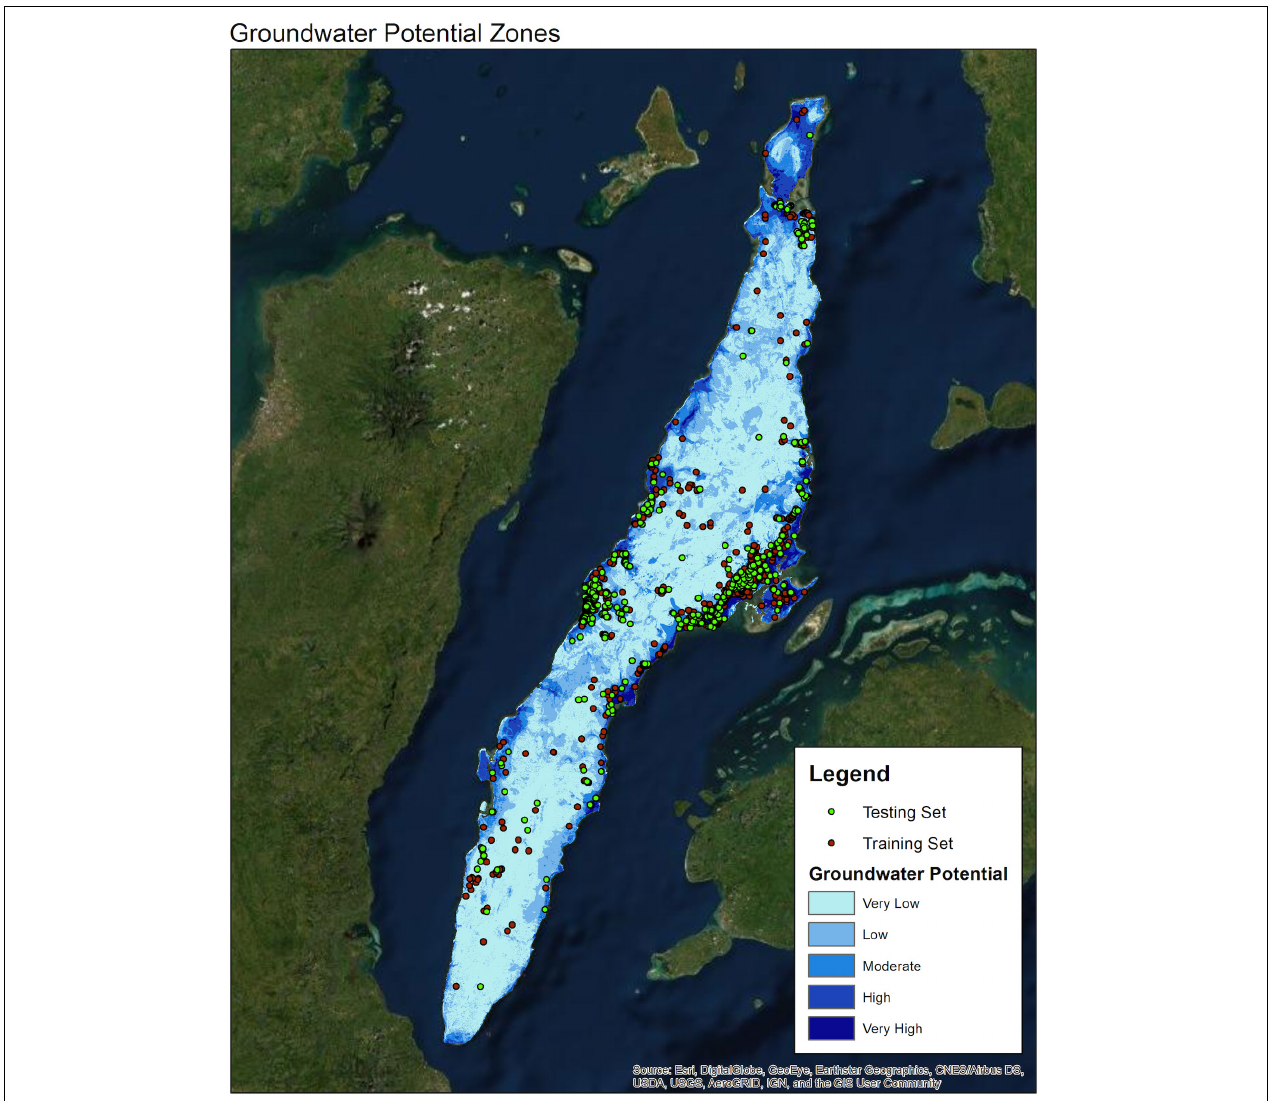
FIGURE 2 | Locations of existing wells ( N = 1,204) across the Cebu and Mactan islands of Cebu province distinguished among training (842 wells) and training set (362 wells). Basemap Source: ESRI (2018), DigitalGlobe, GeoEye, Earthstar Geographics, CNES/Airbus DS, USDA, USGS, AeroGRID, IGN, and the GIS User